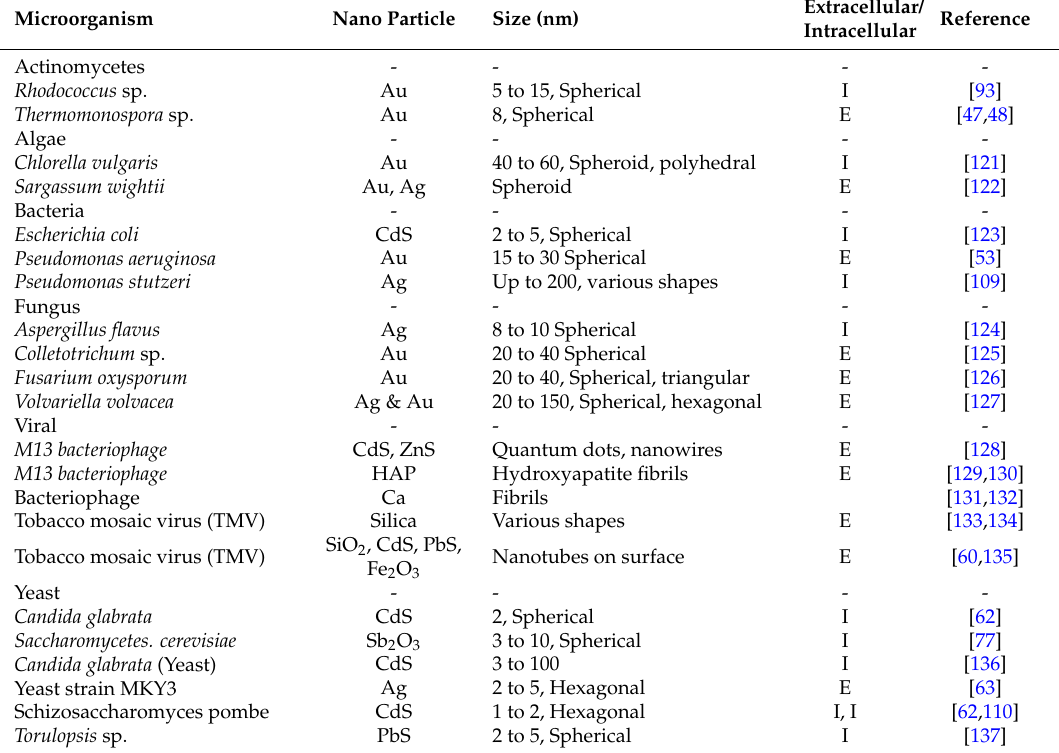
Table 1. A selection of microorganisms used to synthesize nanoparticles.